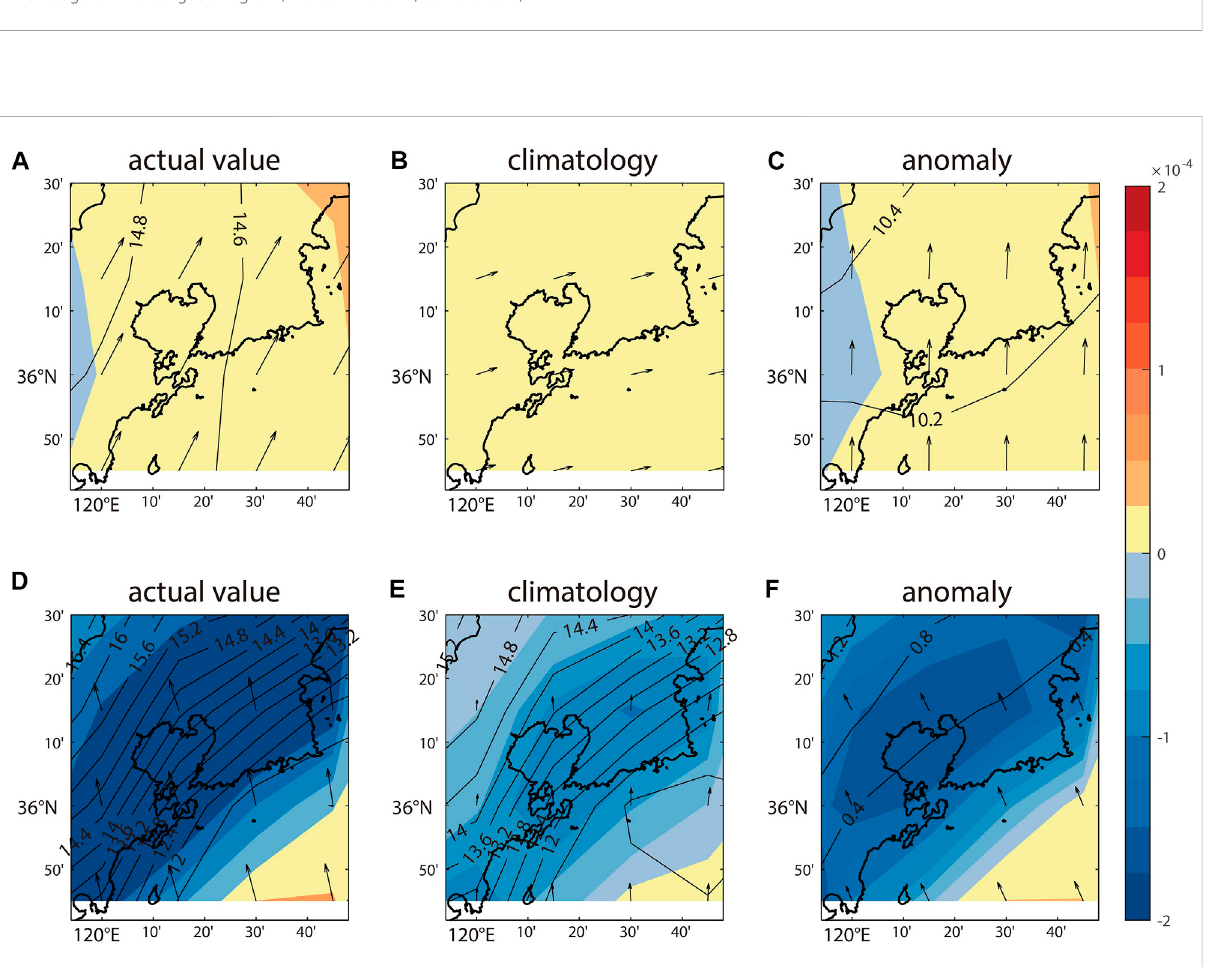
FIGURE 9 Compositeresults of time-averaged temperature advection (K/s; shading) during day 0 00 – 23 LST at925 hPa (top) and at thesurface (bottom) for all SFP events based on ERA5. Left, middle, and right panels are actual, climatological, and anomalous values, respectively. The advection is given by shading, and temperature ( ° C) is given by contour. The arrows represent